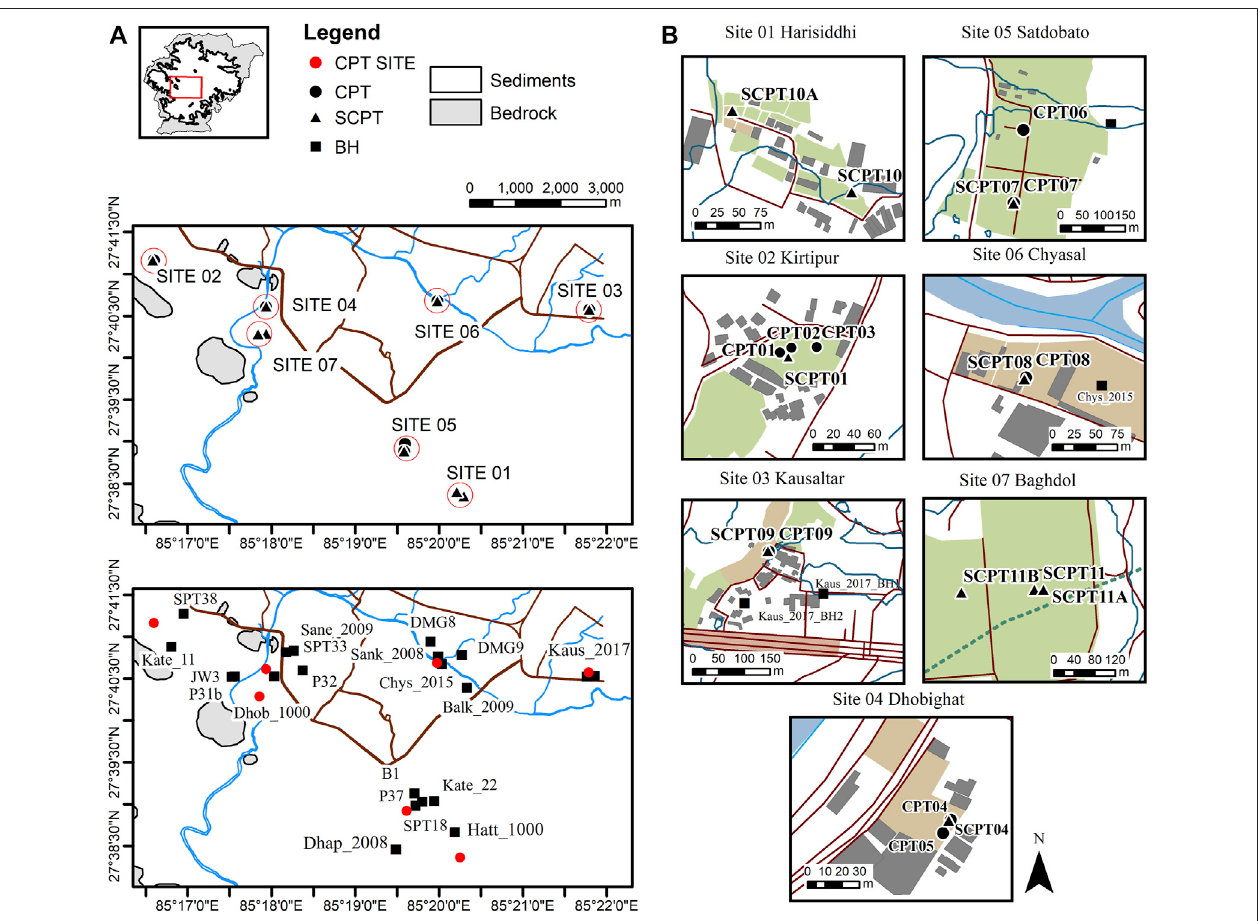
FIGURE1|(A) SitelocationplanshowingCPTinvestigationsitesandhistoricalboreholerecordsfromSAFER/GEO-591(Gilderetal.,2019a;Gilderetal.,2020) (B) the seven CPT investigation sites.